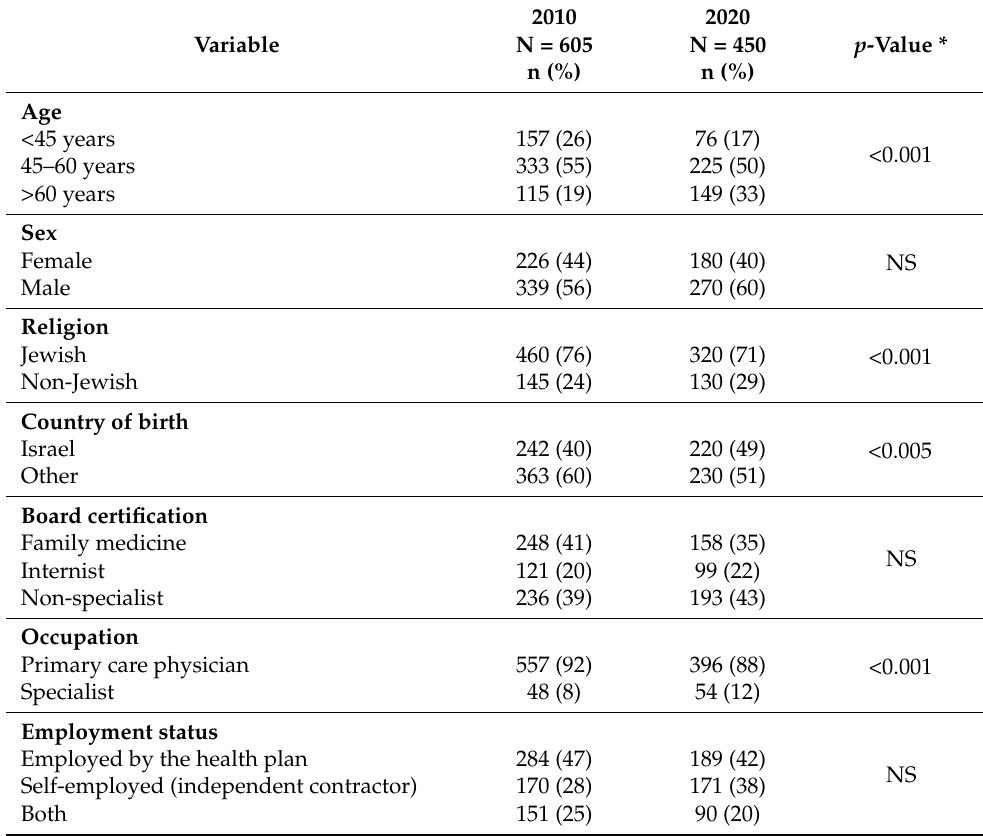
Table 1. Demographic and work characteristics of the study